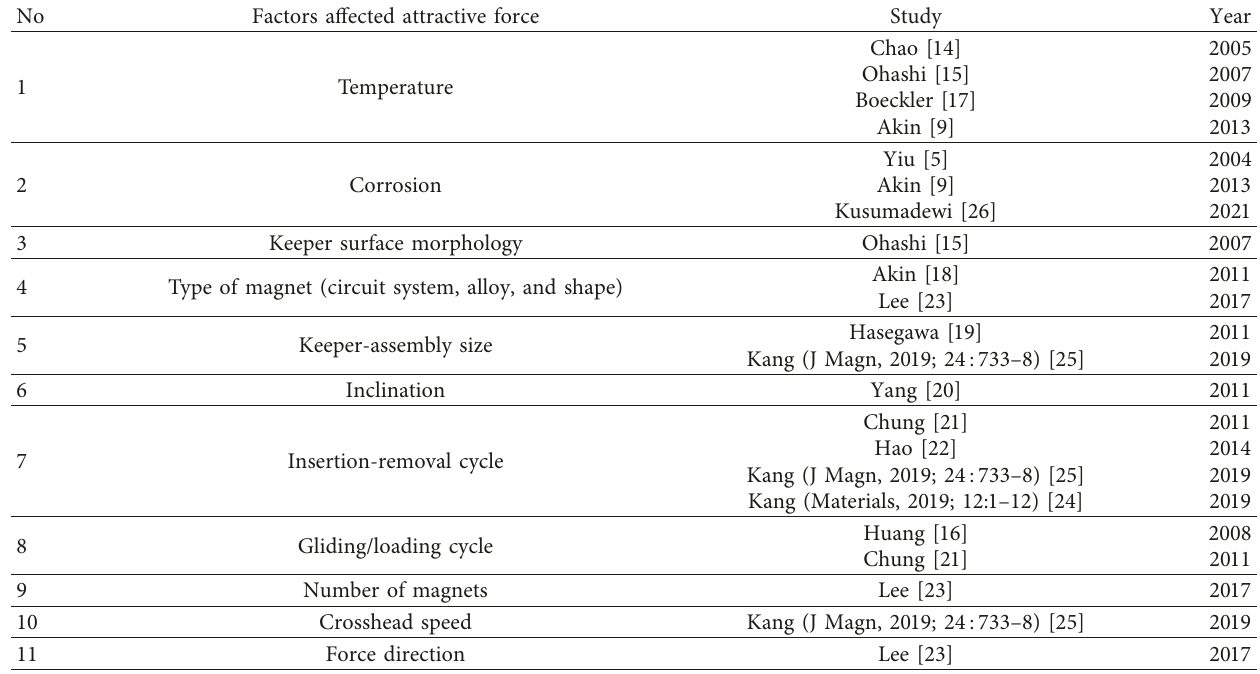
Table 2: Factors that affected attractive magnetic force based on reviewed